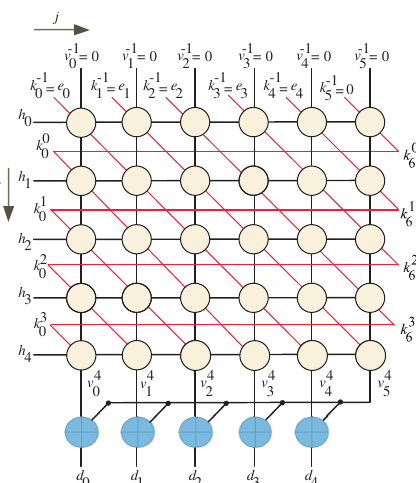
Figure 1. DG of the adopted algorithm for n =